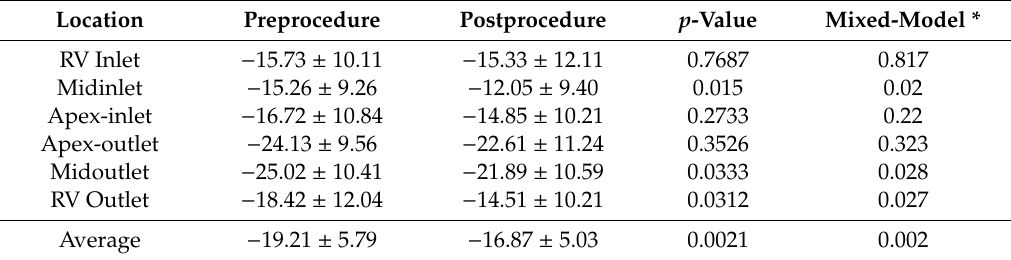
Table 3. Change of strain in each RV segment on VVI (%) after ASD device closure.